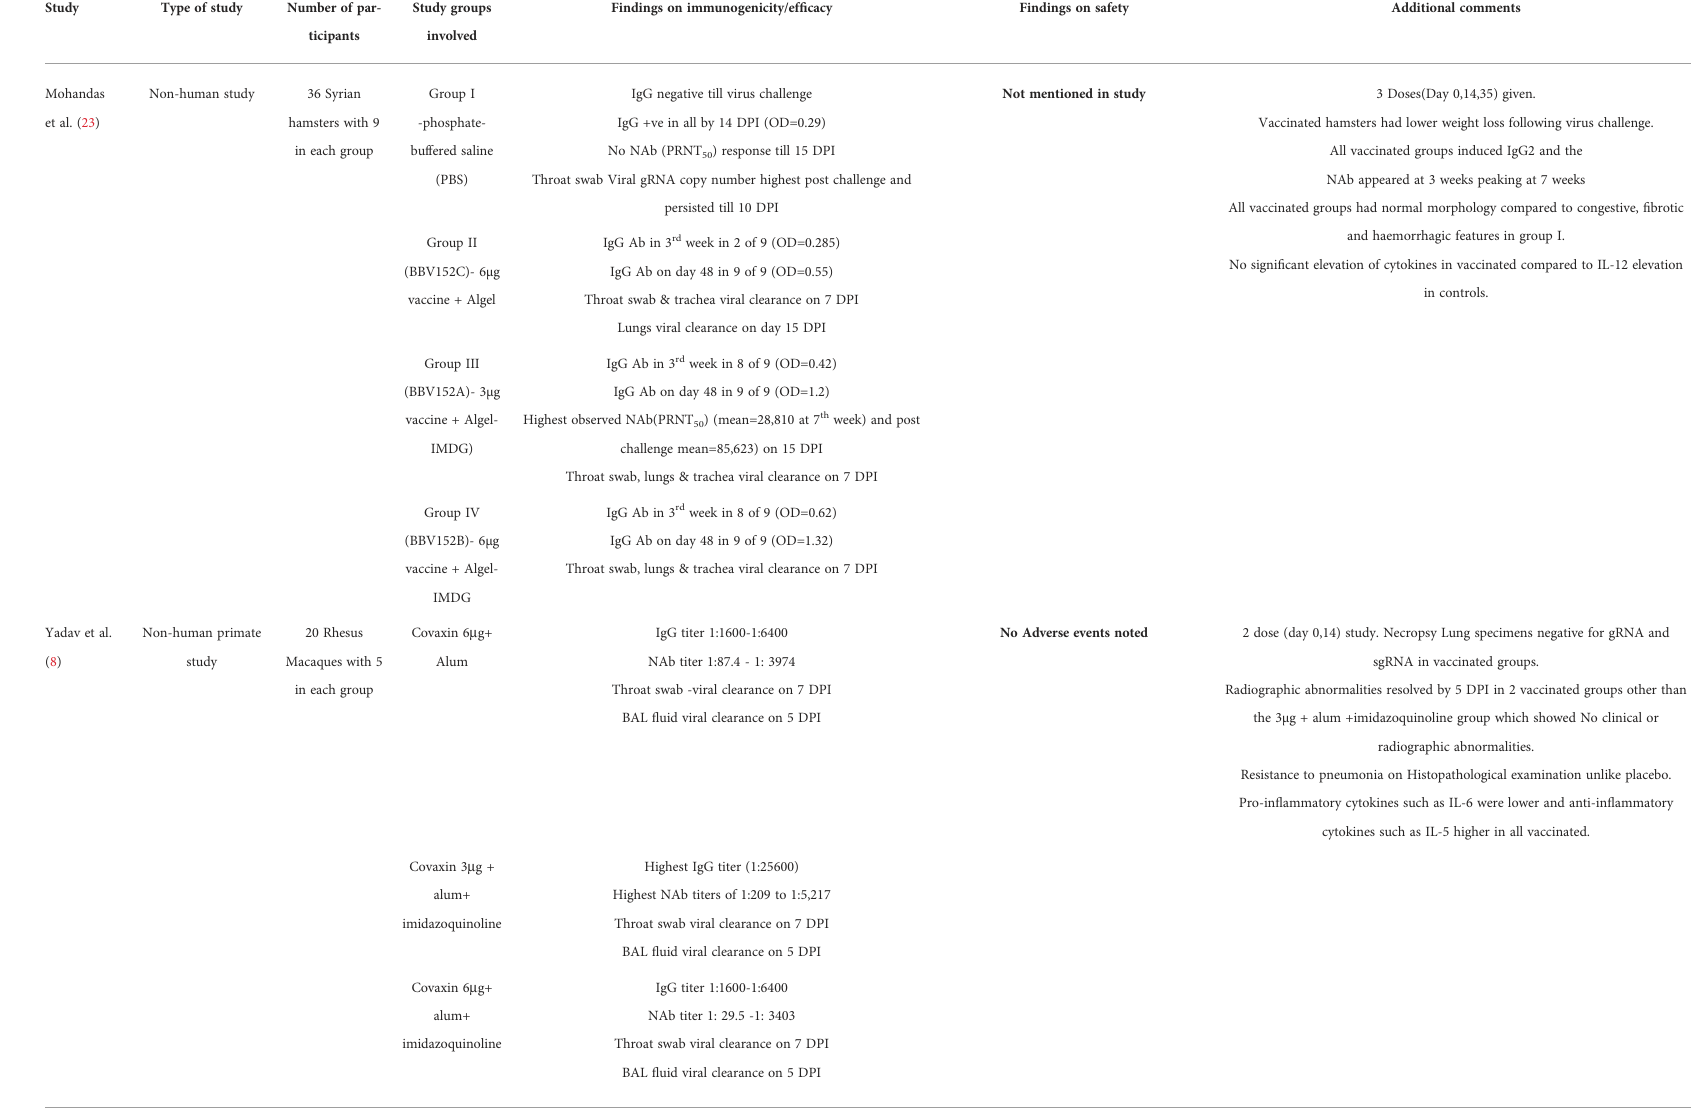
TABLE 2 List of studies on the puri fi ed inactivated SARS-CoV-2 vaccine